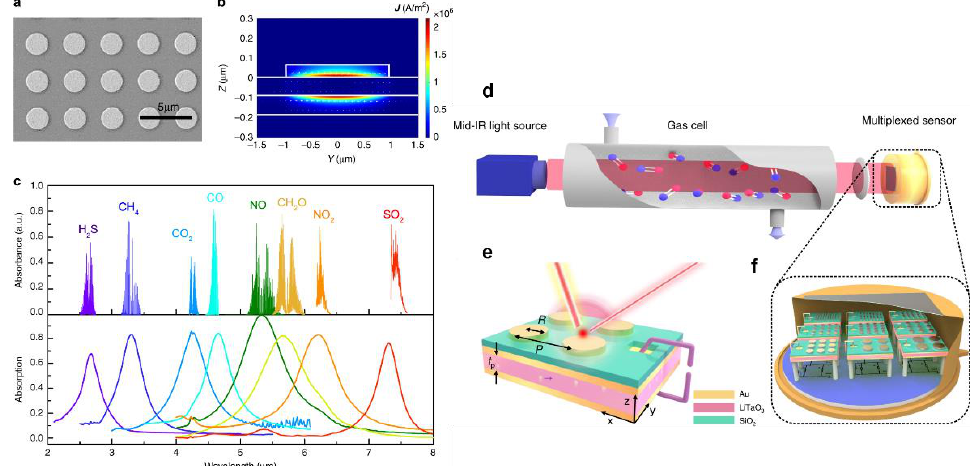
Figure 9. The spectral and near-field properties of the plasmonic metamaterial absorber. ( a ) Scanning electron microscope (SEM) image of the gold nanodisk antenna array. ( b ) The distribution of light-induced current density magnitude |J| and current density vector J in the yz cut-plane of the MIM absorber. ( c ) The measured absorption spectra of eight fabricated MIM absorbers and the infrared absorption bands of eight target gases: H 2 S, CH 4 , CO 2 , CO, NO, CH 2 O, NO 2 and SO 2 . ( d ) Schematic diagram of the gas sensing system based on the proposed NDIR architecture with an array of narrowband PMA-integrated pyroelectric elements used as the spectral sensor. The method comprises three modules: a broadband light source, a gas cell and a multi-element sensor, together with necessary focusing optics. ( e ) The geometry of the narrowband detection element. From top to bottom are the Au nanodisk antenna, the silicon dioxide spacer, the gold backplate that is also used as the top electrode of the pyroelectric element, the lithium tantalate (LT) substrate and the bottom gold electrode, ( f ) the integrated package of the multiple pyroelectric elements with different detection wavelengths. [103] © Springer Nature 2020, Nature